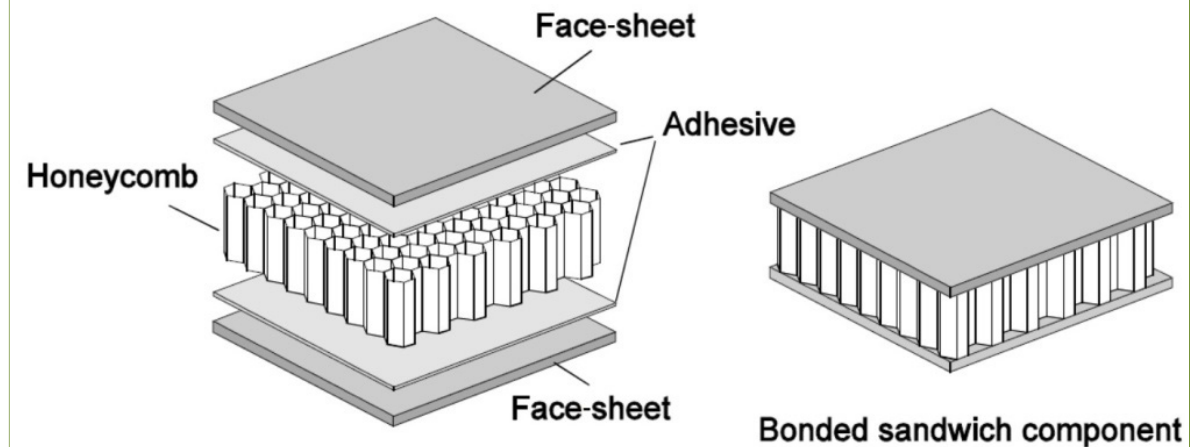
Figure 2. Construction of honeycomb core sandwich plate.